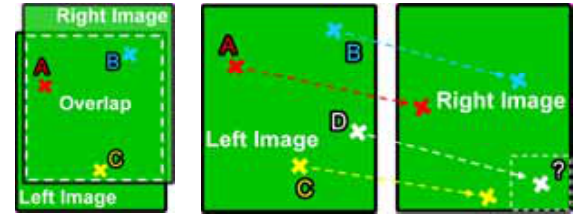
Figure 4. Two functions of AFTP: overlap estimation(left), and searching window prediction